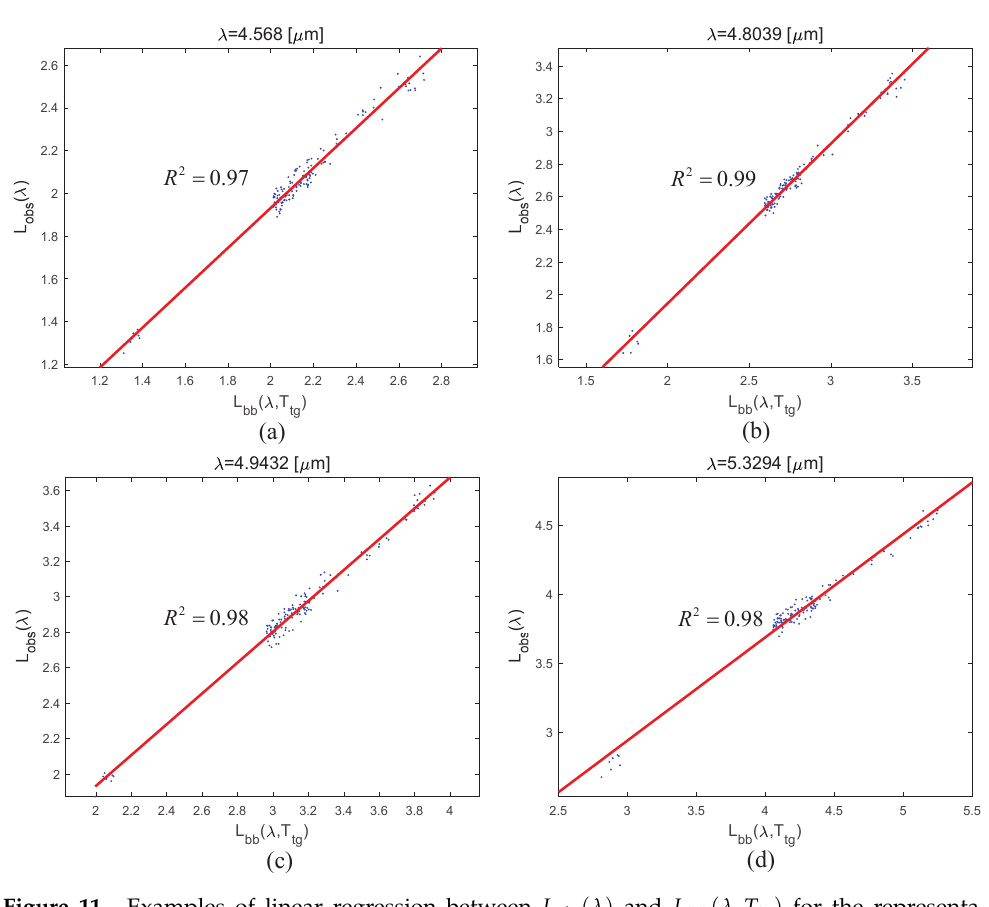
Figure 11. Examples of linear regression between L obs ( λ ) and L BB ( λ , T tg ) for the representa- tive bands: ( a ) λ = 4.568 [ µ m ] , ( b ) λ = 4.8039 [ µ m ] , ( c ) λ = 4.9432 [ µ m ] , ( d ) λ = 5.3294 [ µ m ]